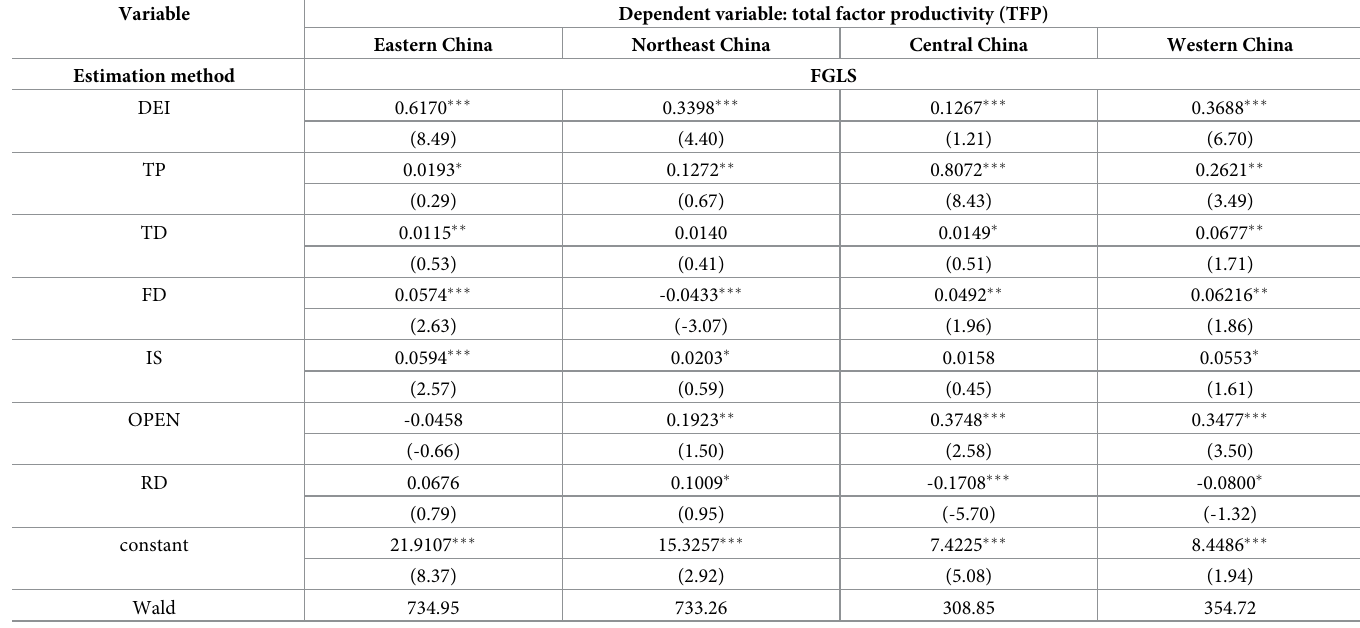
Table 9. Regression results of the regional digital economy in the improvement of total factor productivity.